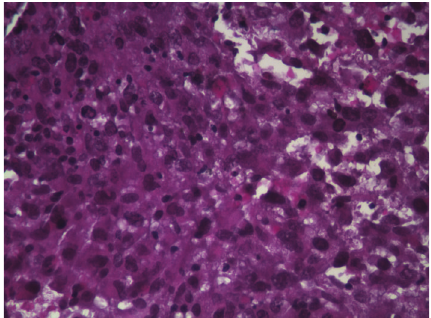
Figure 5: Lung transbronchial biopsy specimen: poorly differenti- ated cluster of neoplastic cells with abundant cytoplasm with hyper- chromatic nuclei. No gland or sheets of squamous cell formation.